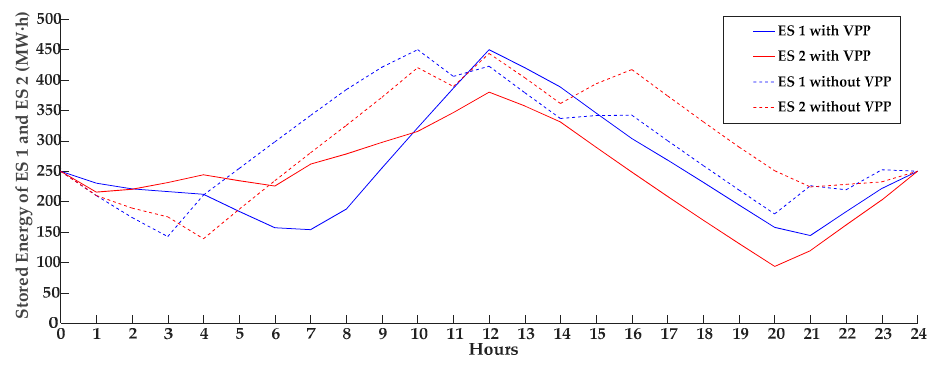
Figure 3. Stored energy of ESs with/without VPP integration.